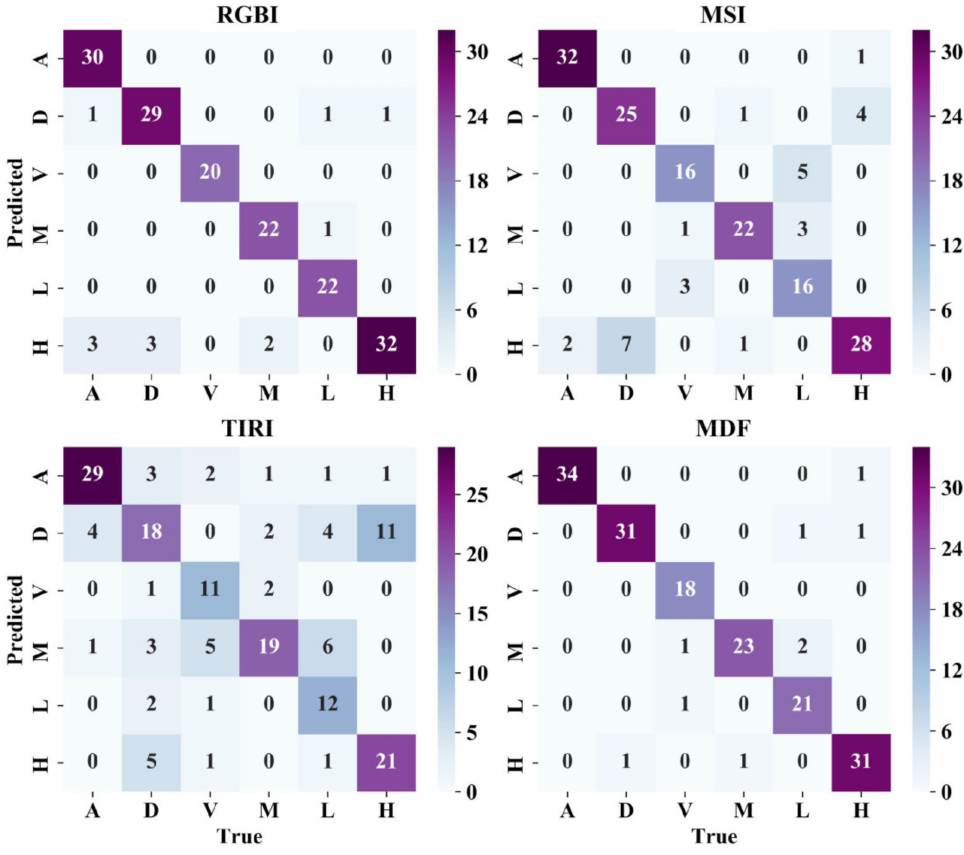
Figure 10. Confusion matrices of RGBI, MSI, TIRI, and MDF models on the test set in the first fold. A: anthracnose class; D: downy mildew class; V: viral disease; M: mites class; L: leafhopper class; H: healthy class.